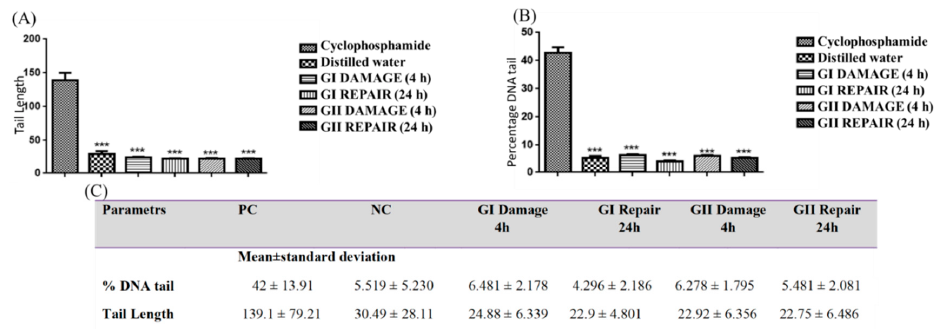
Figure 3. Tail length recorded after analysis of the open comet of the animals after exposure ( A ). Recorded % DNA tail after analysis of the open comet of the animals after exposure ( B ). DNA damage found by group after exposure to PBAT / PPy and PBAT / PPy with nHAp reported as the mean and